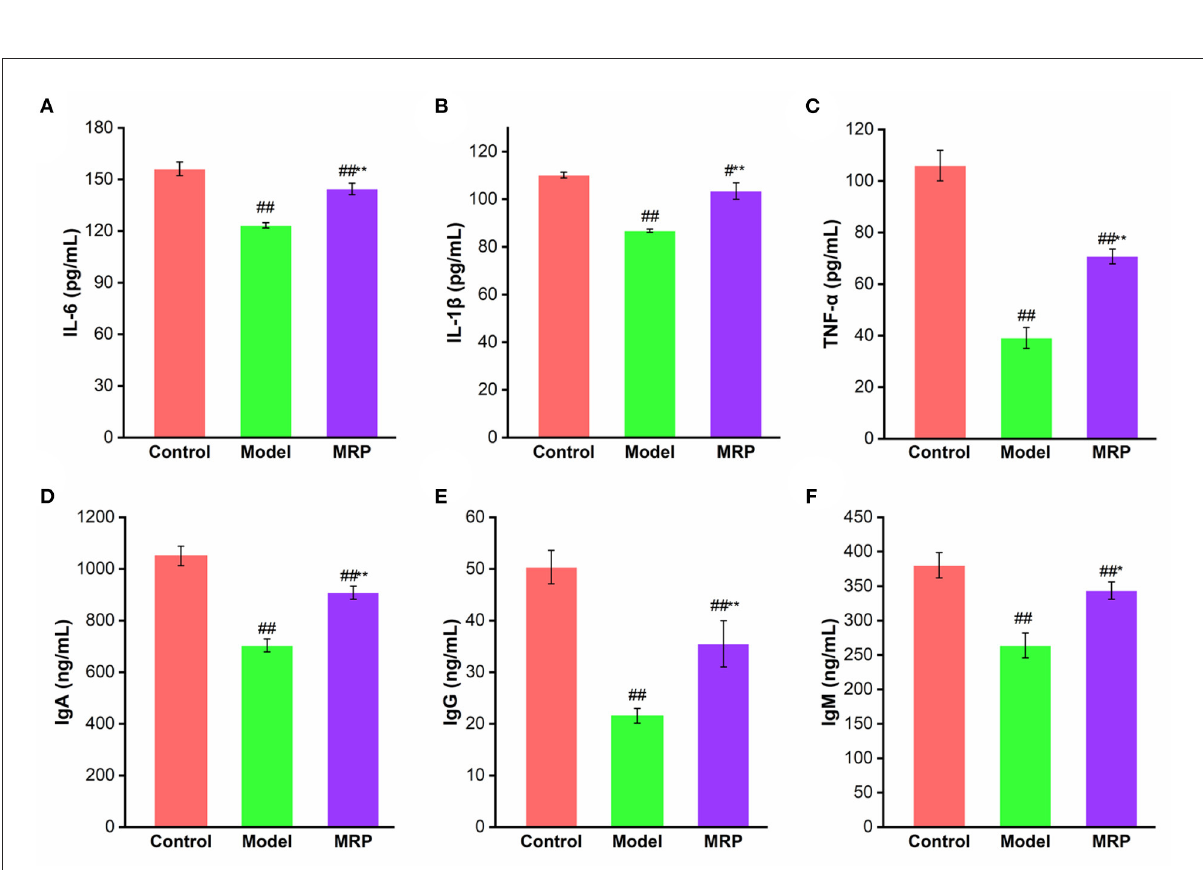
FIGURE6 Effect of MRP on serum levels of IL-6 (A) , IL-1 β (B) , TNF- α (C) , IgA (D) , IgM (E) , and IgG (F) ( n = 10). # P < 0.05 and ## P < 0.01 vs. Control; * P < 0.05 and ** P < 0.01 vs. Model.